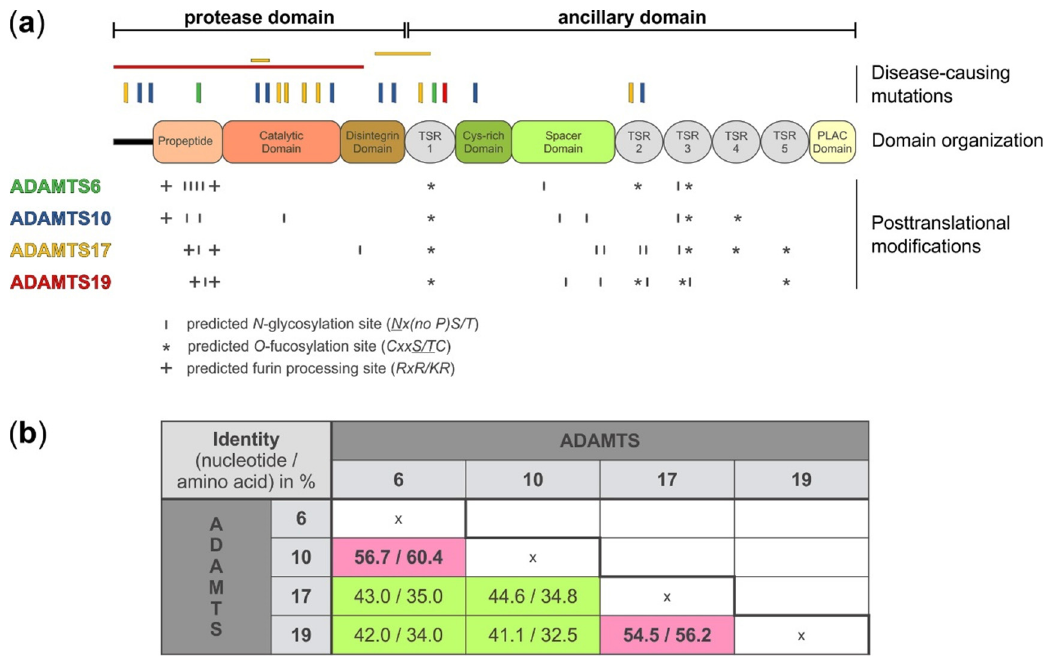
Figure 1. A disintegrin-like and metalloprotease with thrombospondin type 1 motif (ADAMTS)6, 10, 17, and 19 domain organization, location of disease-causing mutations, and sites for putative post-translational modifications. ( a ) Domain organization, depicting the protease and ancillary domain of ADAMTS6, 10, 17, and 19, which have an identical domain organization. However, the four ADAMTS proteases show differences in the number and localization of predicted sites for posttranslational modifications, such as N-glycosylation (http://www.cbs.dtu.dk/services/NetNGlyc/), O-fucosylation, and furin processing which could specify individual substrates, define protein - protein interactions,